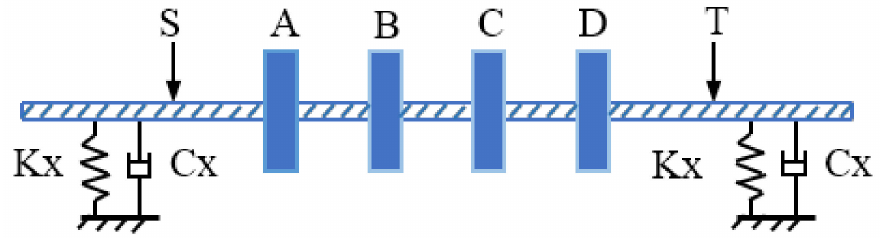
Figure 4. Configuration of the numerical example [47]. (A,B,C,D-four disks on the shaft, Kx- stiffness of bearing, Cx- damping of bearing, S,T- measuring plane locations.)